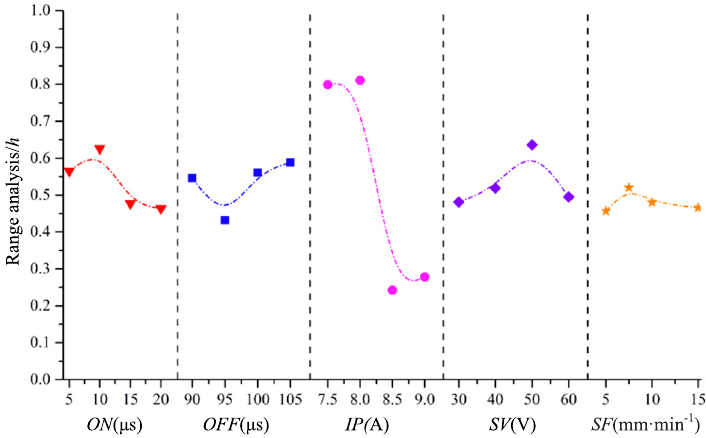
Figure 4: Trend chart of in fl uence on kerf width.